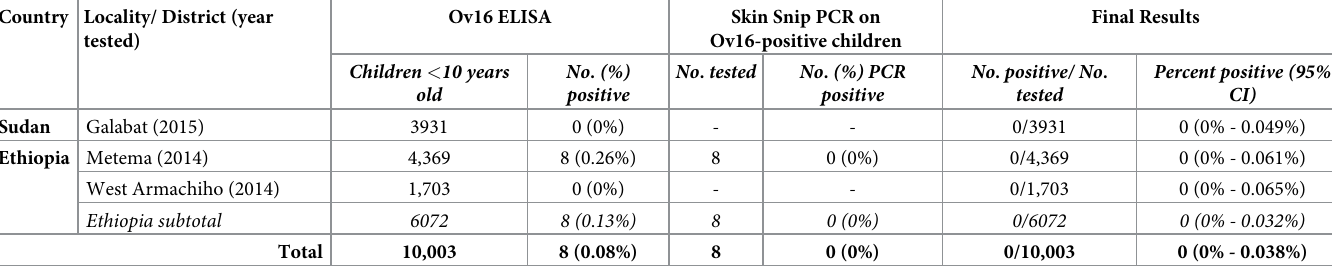
Table 2. Ov16 ELISA and skin snip PCR results from stop MDA assessments in the Galabat-Metema focus (2014–2015). Country Locality/ District (year